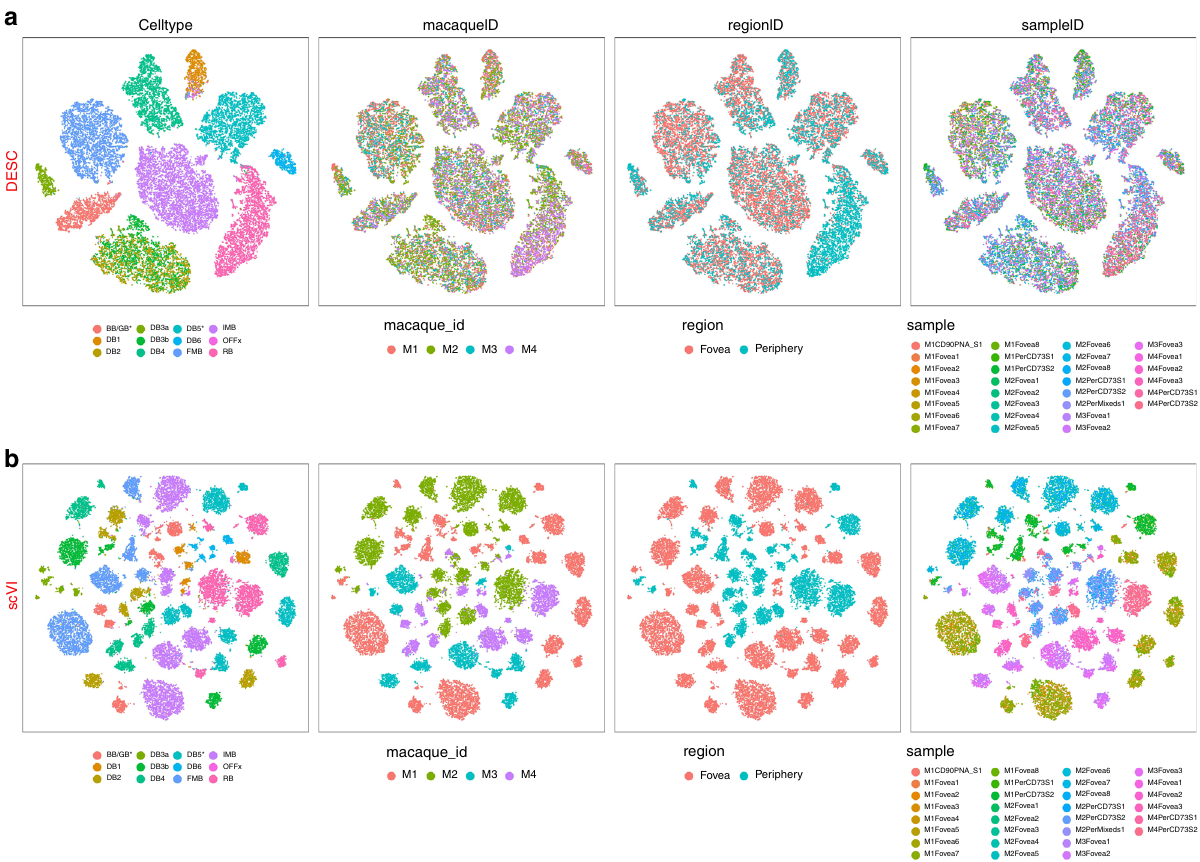
Fig. 3 The Comparison between DESC and scVI when batch information was not provided in the analysis of macaque retina data. a The t-SNE results of DESC when no batch information provided and the cells are colored by cell type, macaque id, region id, and sample id, respectively; b scVI when batch information was not provided and cells are colored by cell type, macaque id, region id, and sample id, respectively. The cells are mixed well by macaque id, region, and sample id in DESC, but are completely separated by macaque id, region, and sample id in scVI. These results indicate that DESC is able to remove complex batch effect without explicit use of batch